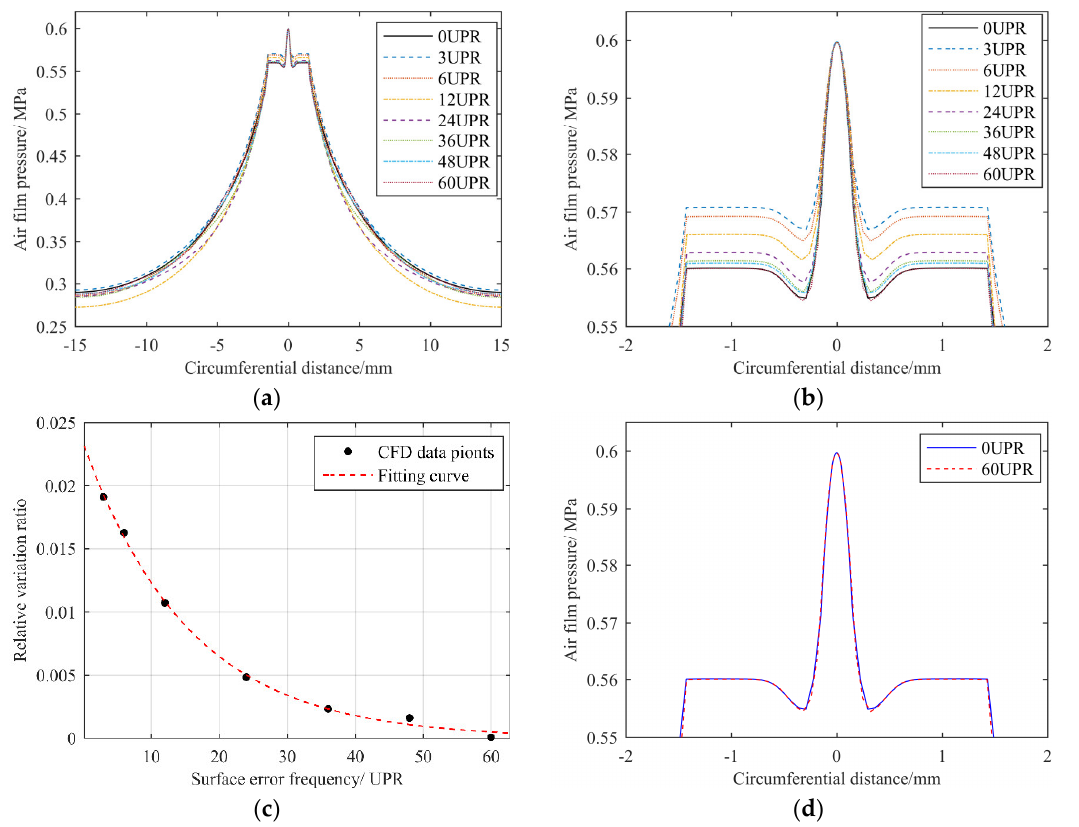
Figure 8. Comparison of CFD results of contour error in different frequencies: ( a ) pressure distribution curve on the rotor’s surface along the circumferential direction; ( b ) local amplified pressure distribution at the position of orifice chamber; ( c ) relative variation ratio of the film pressure under different contour error frequencies; ( d ) comparison of pressure distribution at the orifice chamber with a contour error frequency of 0 UPR and 60 UPR.